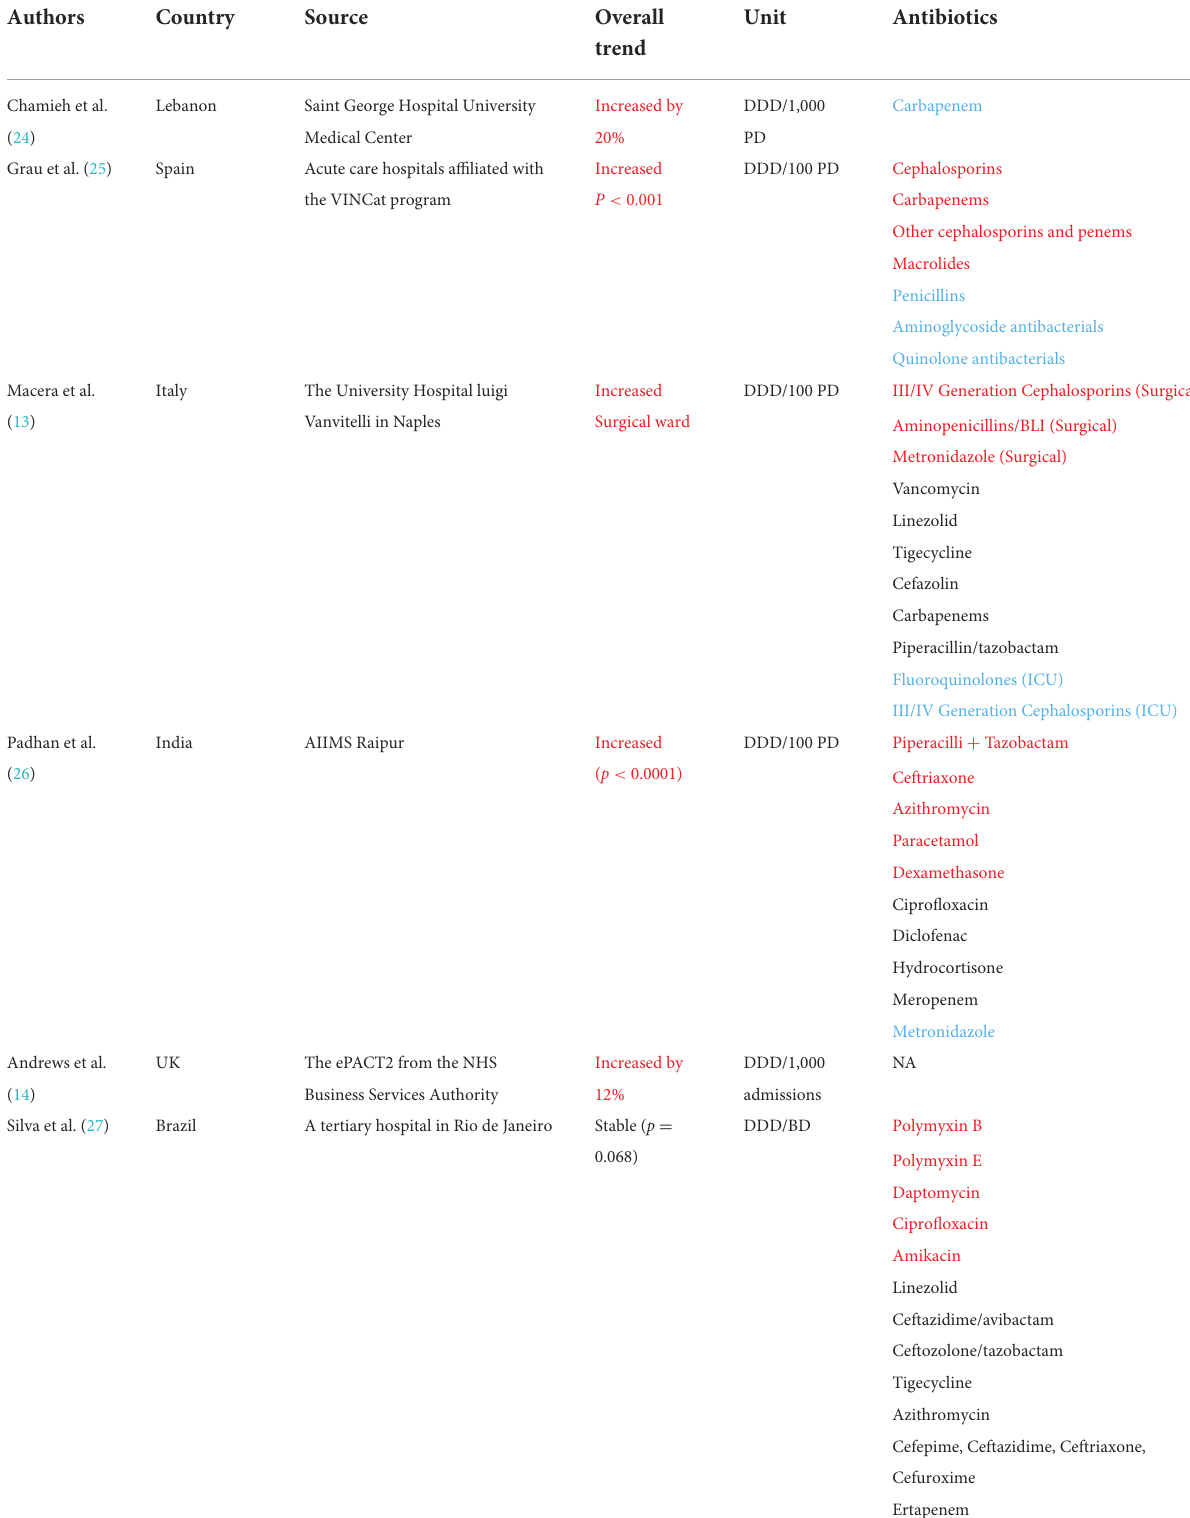
Unit Antibiotics trend